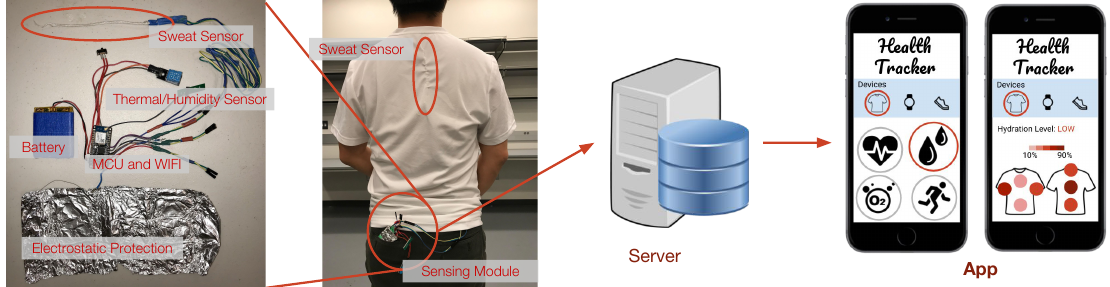
Figure 8. Perspiration level estimation. The sensor measures the sweat quantity of the cotton threads. The system maps the measured voltage to the sweat quantity in mg and estimates each user’s perceived perspiration level based on personal historical data. The measured sweat quantity and estimated perceived perspiration level are displayed on the mobile app